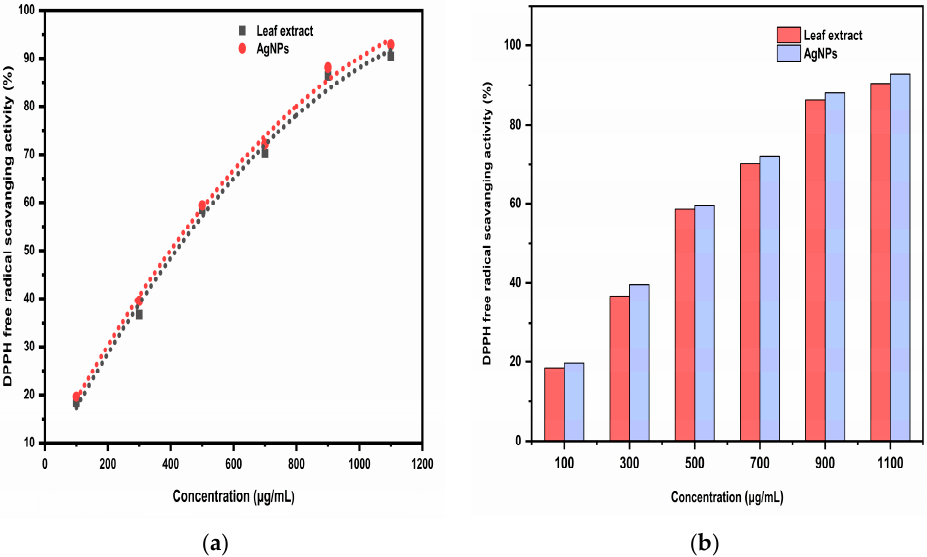
Figure 13. ( a ) Quadratic regression equation for the IC 50 ( μ g/mL) value by DPPH free radical scavenging activity; ( b ) The comparative IC 50 ( μ g/mL) of the aqueous leaf extract and the biosynthesized AgNPs.